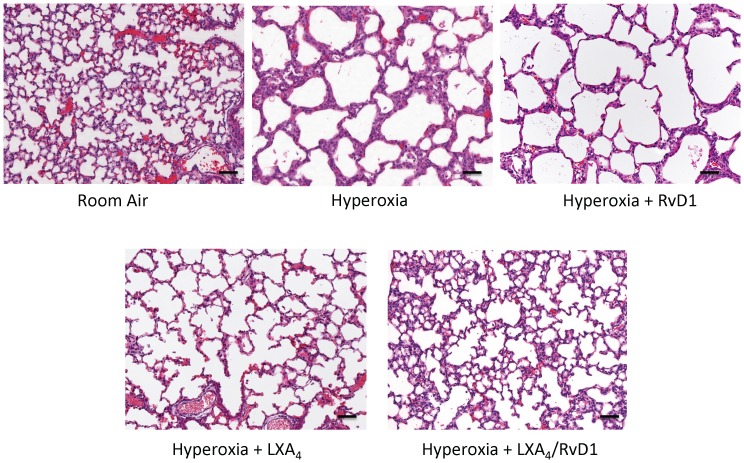
Lung histology by treatment group.Representative images of H and E stained sections were taken at an original magnification of 200x. Bars represent 100 µm. RvD1, Resolvin D1; LXA4, Lipoxin A4.